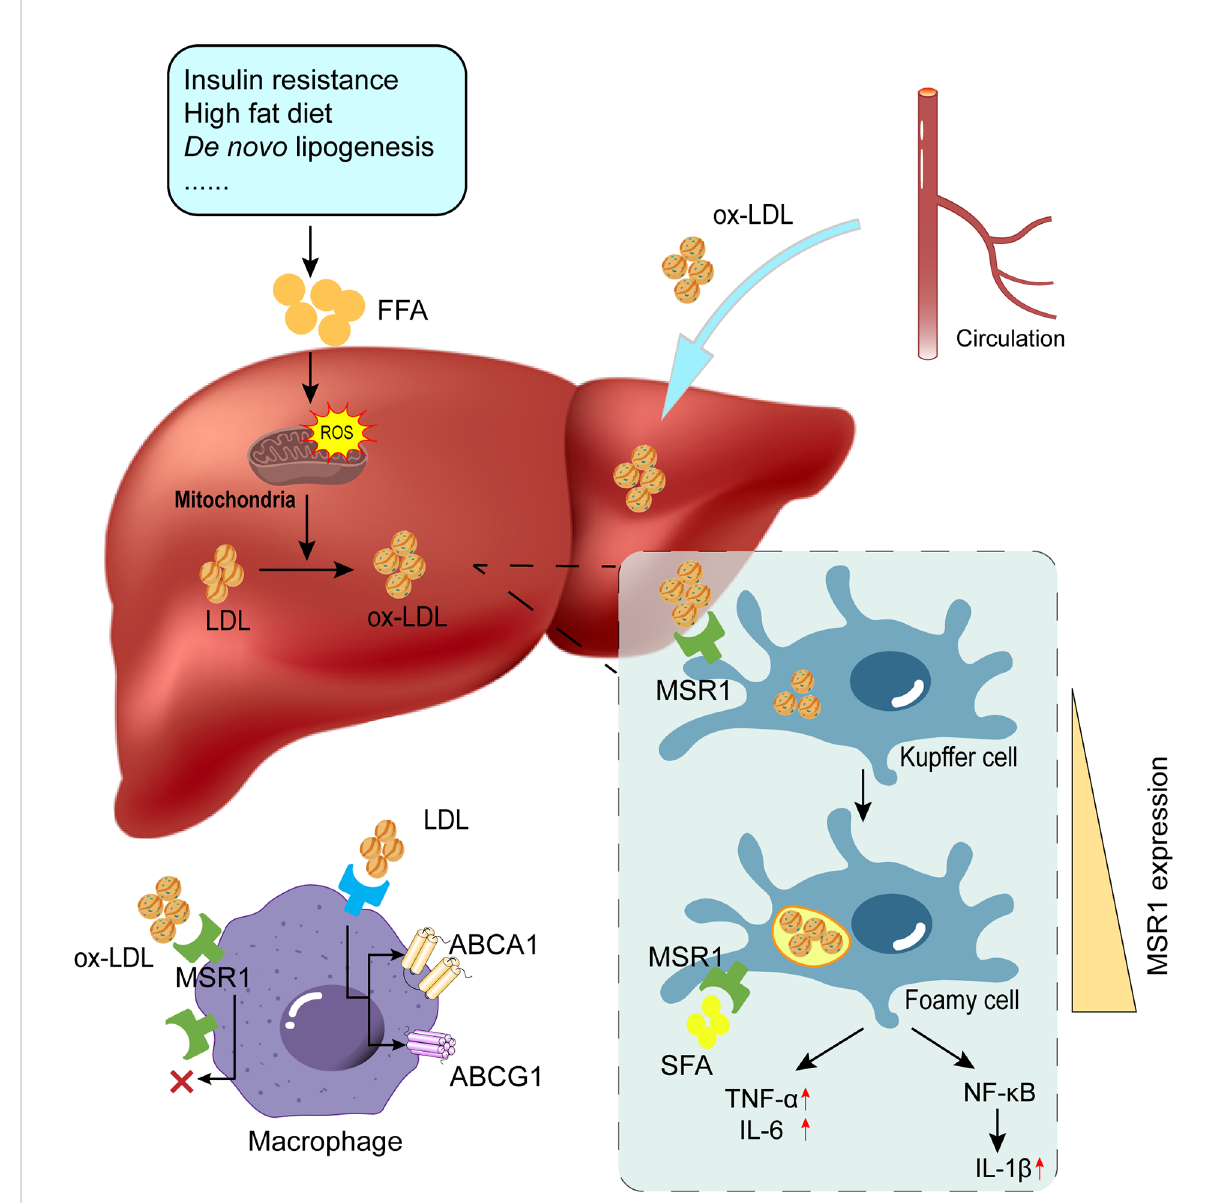
FIGURE 3 Role of MSR1 in foamy cell formation. Due to factors such as insulin resistance and overnutrition, the occurrence of lipid accumulation and subsequent ROS production promotes the conversion of modi fi ed lipids (e.g., ox-LDL and ac-LDL). MSR1 is primarily responsible for ox-LDL uptake. With unrestricted uptake of ox-LDL and limited lipid ef fl ux, KCs will convert into foamy cells. Concomitantly, MSR1 expression on the cell surface is also up-regulated upon various stimulation. ROS, reactive oxygen species; LDL, low-density lipoprotein; ox-LDL, oxidized low- density lipoprotein; KCs, Kupffer